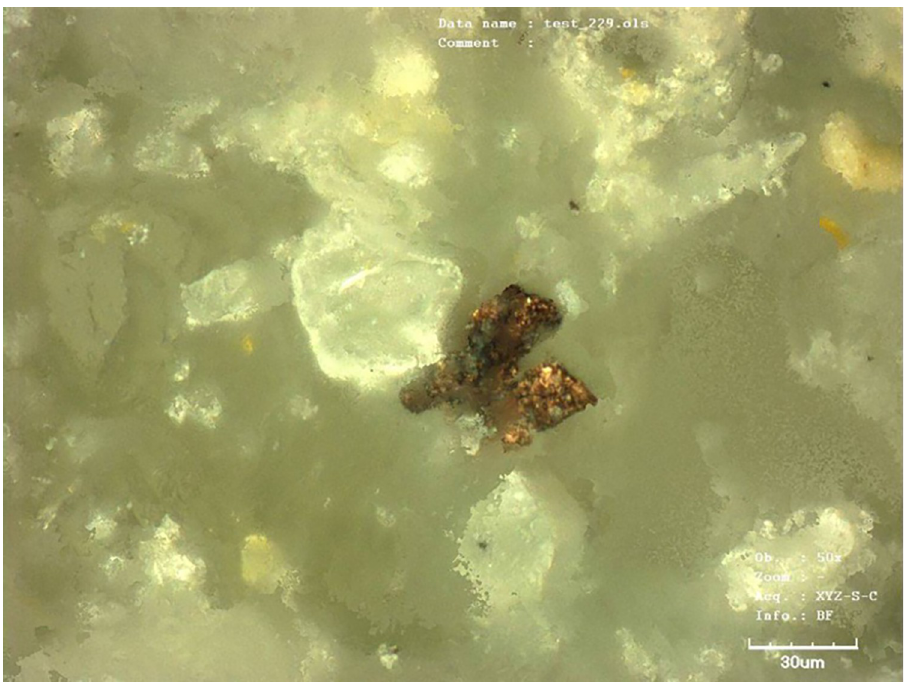
Fig 5. Experimental working up the surface of the sandstone block by the tool made of copper. Microsplinter of the copper from the tool in the structure of the worked surface (photo: M. Cihla).